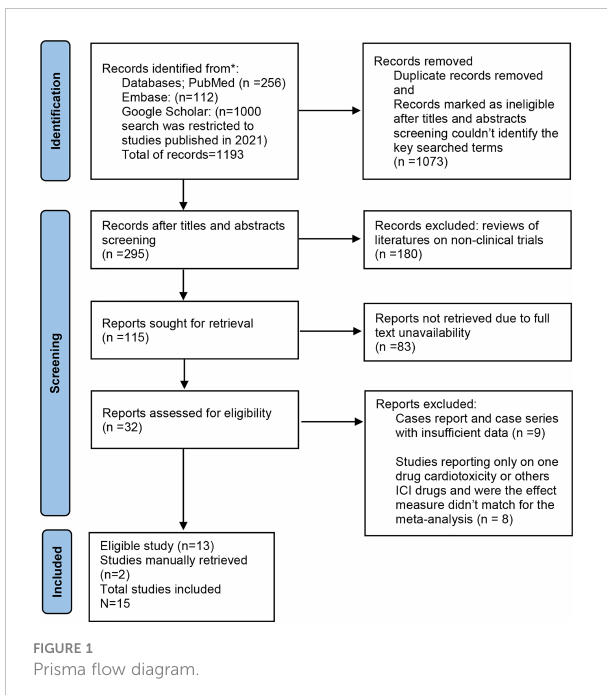
FIGURE 1 Prisma fl ow diagram.